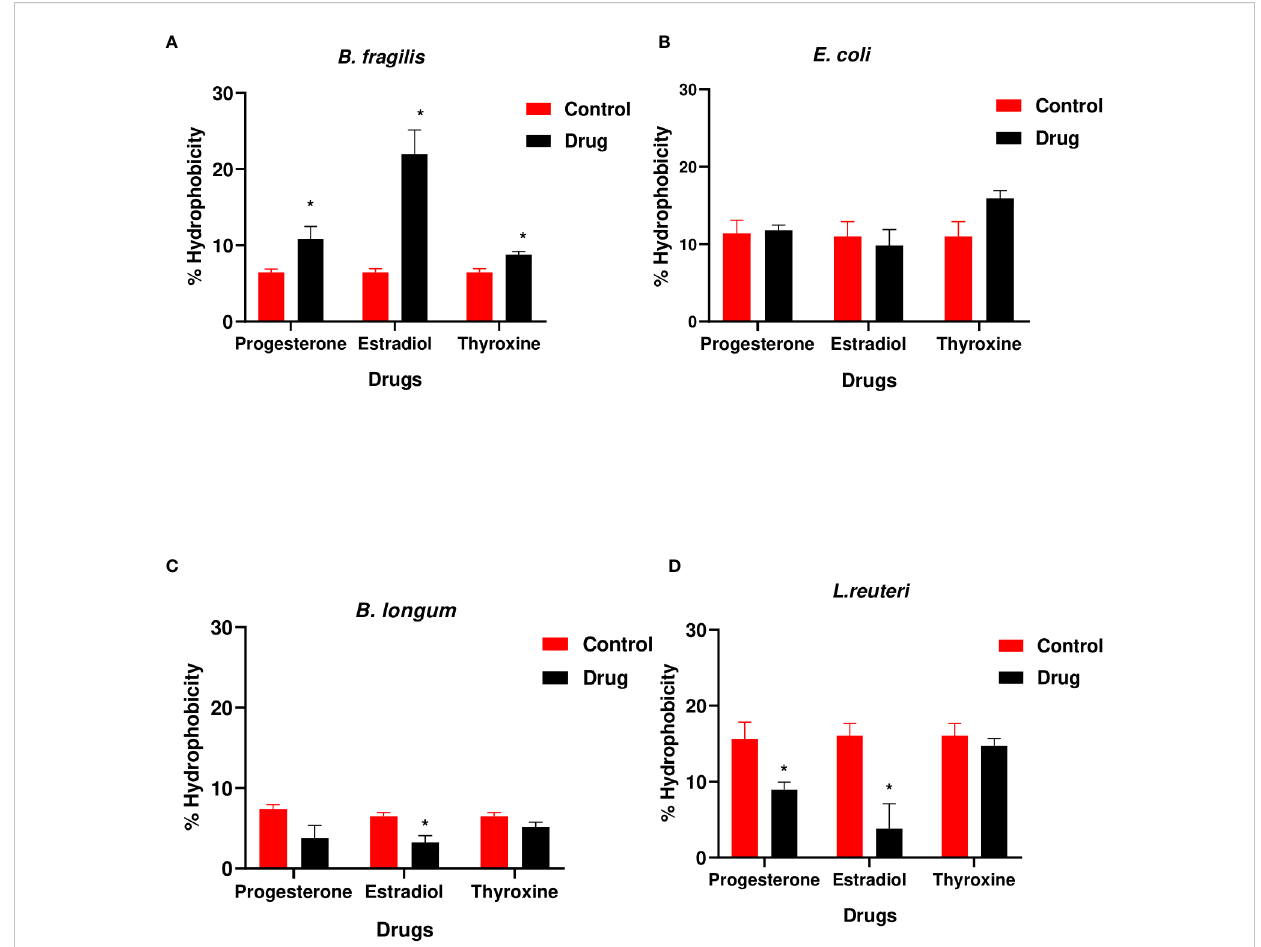
FIGURE 3 Hydrophobicity of bacteria under the effect of hormonal drugs. Change in percentage hydrophobicity of (A) B. fragilis ; (B) E. coli; (C) B. longum; (D) L. reuteri with hormonal drugs after incubation at 37 °C for 60 min. Values were expressed as the mean of the percentage of three experiments with error bars (SE). Tested hormonal drugs include progesterone, ethinyl estradiol, and L-thyroxine in their intestinal concentrations, 211.99, 0.562, and 0.0481µM, respectively. Control represents the bacteria in addition to DMSO. Multiple unpaired t-test along with Holm-S ̌ ı ́ da ́ k for multiple corrections was used to statistically compare the effect of different drugs on bacterial hydrophobicity. * Signi fi cant difference